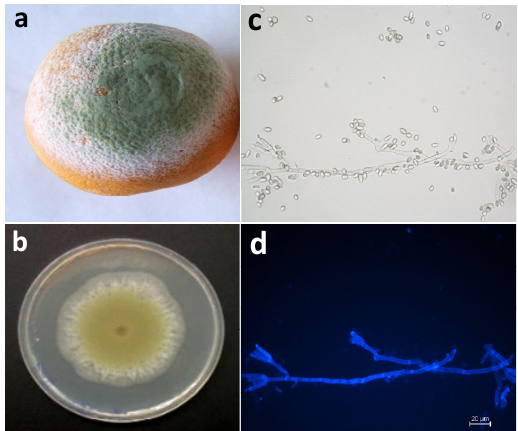
Figure 1. Green mold decay in orange fruit infected with Penicillium digitatum . ( a ) Orange fruit with green mold symptoms caused by P. digitatum ; ( b ) typical aspect P. digitatum growing on PDA plates; ( c ) P. digitatum conidiphore with conidia borne terminally in chains observed by bright-field optical microscopy; ( d ) P. digitatum with fluorescence after staining with CFW.